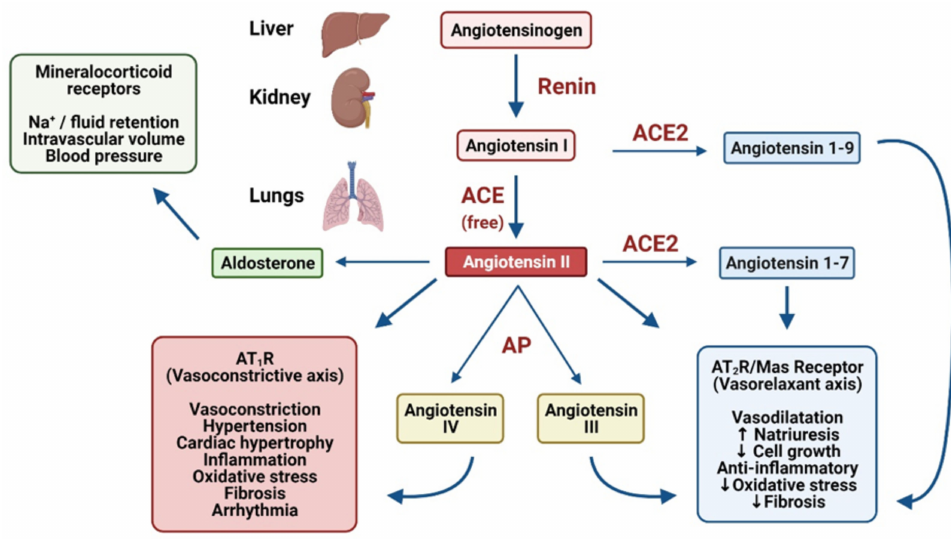
Figure 2. A summary of the action of enzymes involved in the RAAS. ACE, Angiotensin converting enzyme (ACE); AP, aminopeptidases. Figure created with